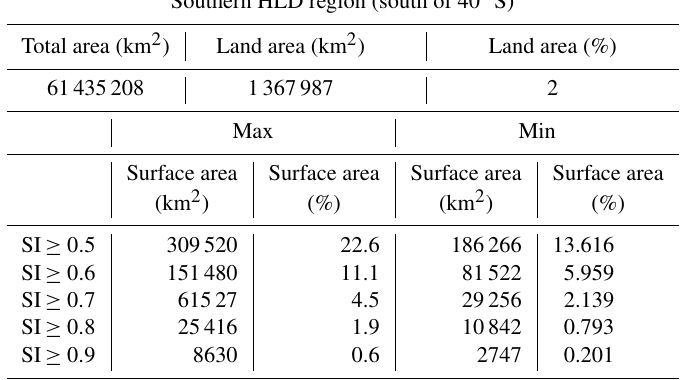
Table 3. Relevant surfaces for the southern HLD region: surface of the total area of the region, surface of land area within the region (km 2 and % of the total surface), and total surface (km 2 and % of the land surface) of areas with SI values above thresholds (0.5 for surfaces with at least “higher” dust emission potential, 0.7 for surfaces with at least “high” dust emission potential, and 0.9 for surfaces with the “highest” dust emission potential) in maximum (max) and minimum (min) seasonal values; values are derived from UNCCD